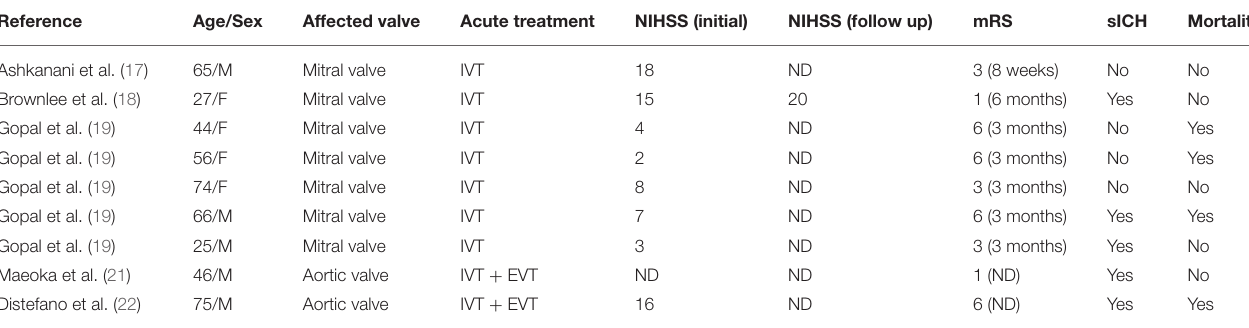
TABLE 2 | Summary of clinical characteristics in reported case series of IE presenting as AIS treated with IVT.